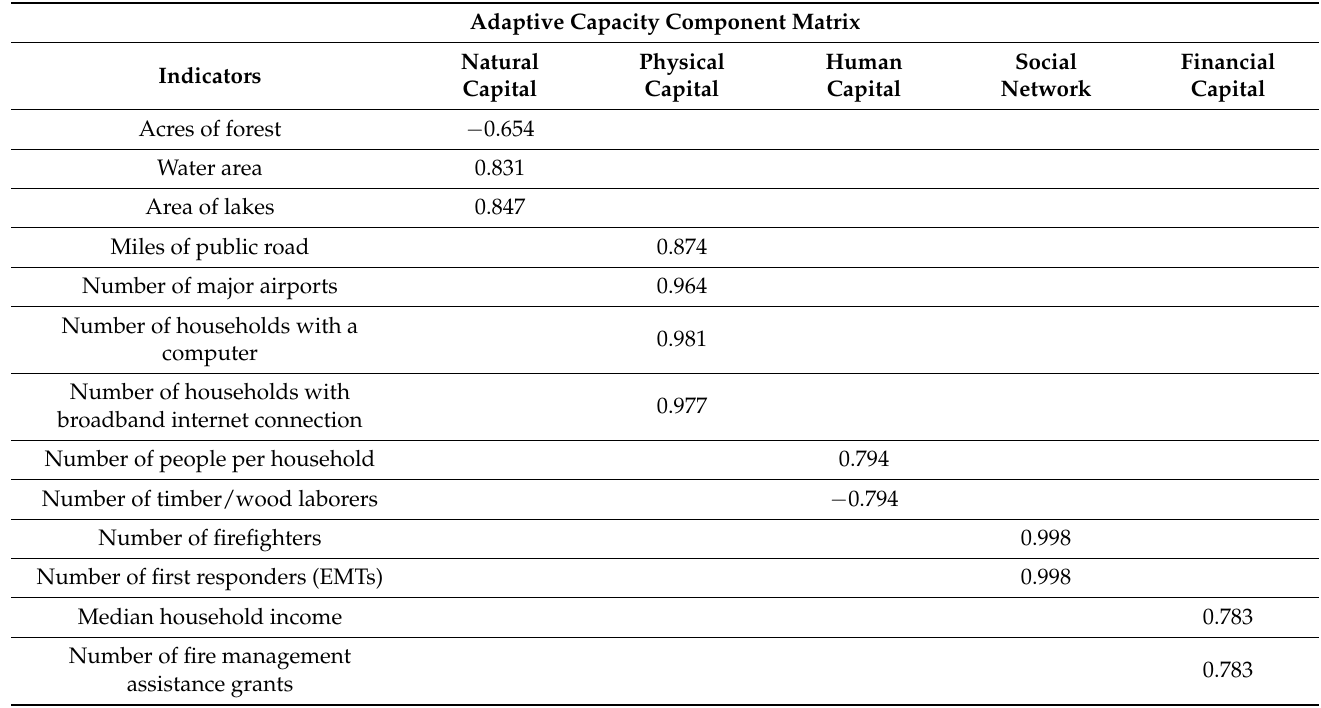
Table A6. A matrix loading table, showing each indicator variable for the adaptive capacity contributing factor and its respective loading into each major component (social network, natural, physical, human, and financial capital).